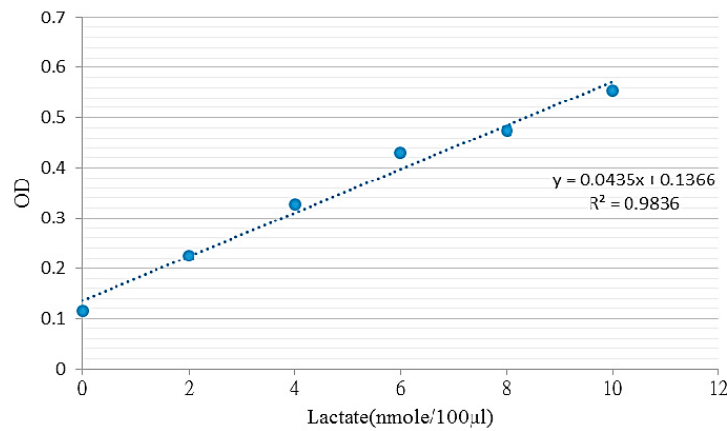
Figure 9. Relationship between lactic acid standard concentration and OD value.